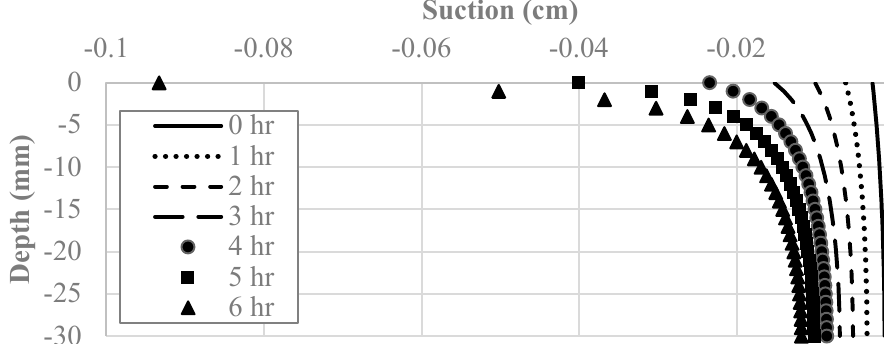
15 of 25 Figure 9. The effect of different additives on the maximum radial shrinkage, rs max . 4.2. Hydro-Mechanical Model 4.2.1. Hydraulic Model Figure 10 depicts the suction along with the depth of the soil layer, with the time step representing each 60-min increment shown. These curves are the same for each soil im-